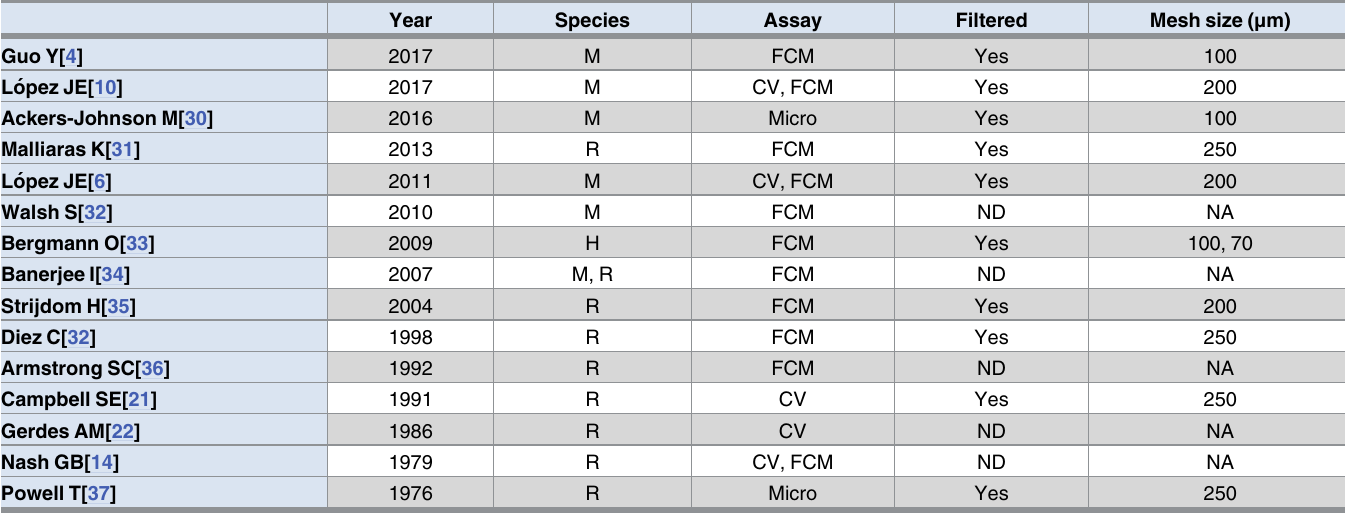
Table 1. Ventricular myocyte isolations and cell filtering.